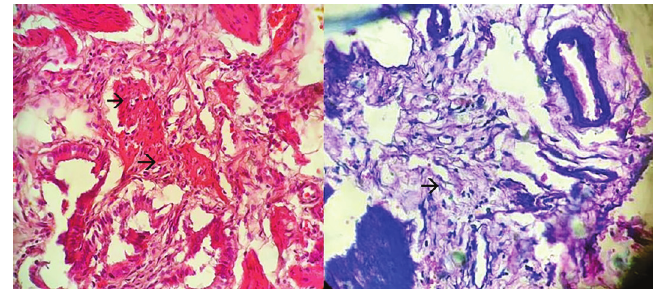
Figure 3. Gallbladder tissue examination (A) Chronic inflammation cells without malignant cells (pointed by arrow). (B) Acid-fast bacilli (pointed by arrow). The conclusion was that chronic cholecystitis could be caused by